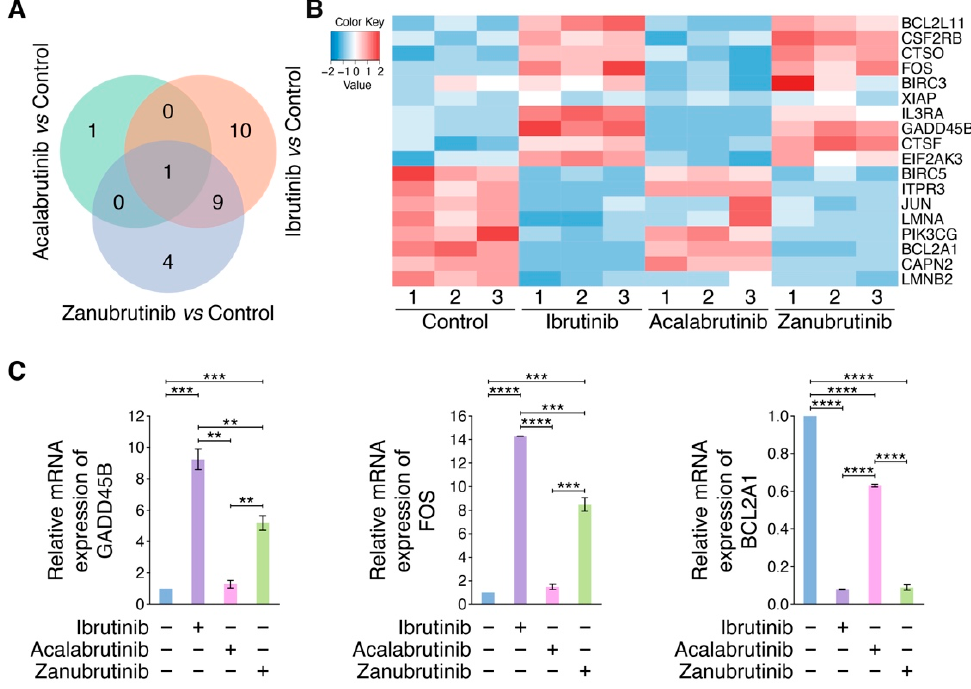
Figure 2. RNA-seq identifies apoptotic genes regulated by BTKis. ( A ) Venn diagram illustrating the number of genes involved in apoptosis, which were commonly and differentially regulated by the treatment of Ibrutinib, Acalabrutinib or Zanubrutinib compared to control treatment in HUVECs. ( B ) Heatmap of DEGs implicated in apoptosis regulated by Ibrutinib, Acalabrutinib and Zanubrutinib versus control in HUVECs. Red represents upregulation and blue indicates downregulation. ( C ) Analysis of mRNA expression of GADD45B , FOS and BCL2A1 in endothelial cells via qRT-PCR ( n = 3), which were treated with Ibrutinib, Acalabrutinib or Zanubrutinib (2 μ M). Data are shown as mean ± SEM; ** p < 0.01; *** p < 0.001; **** p < 0.0001, as calculated using one-way ANOVA with Tukey’s multiple comparisons test.